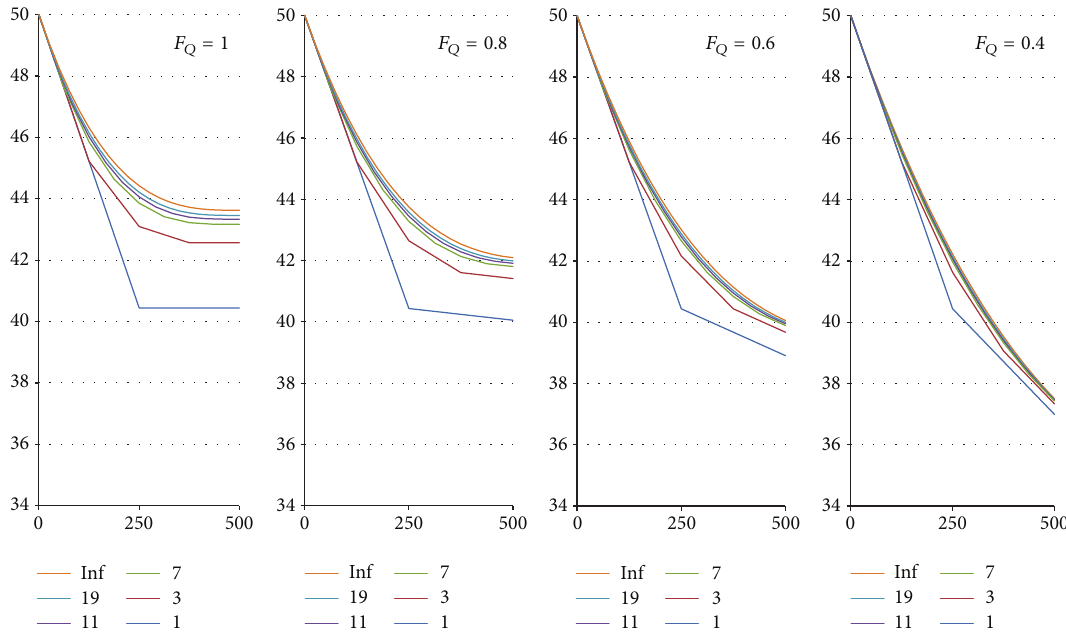
Figure 1: Hydraulic grade lines in one single line for various uniform distributions of demand.